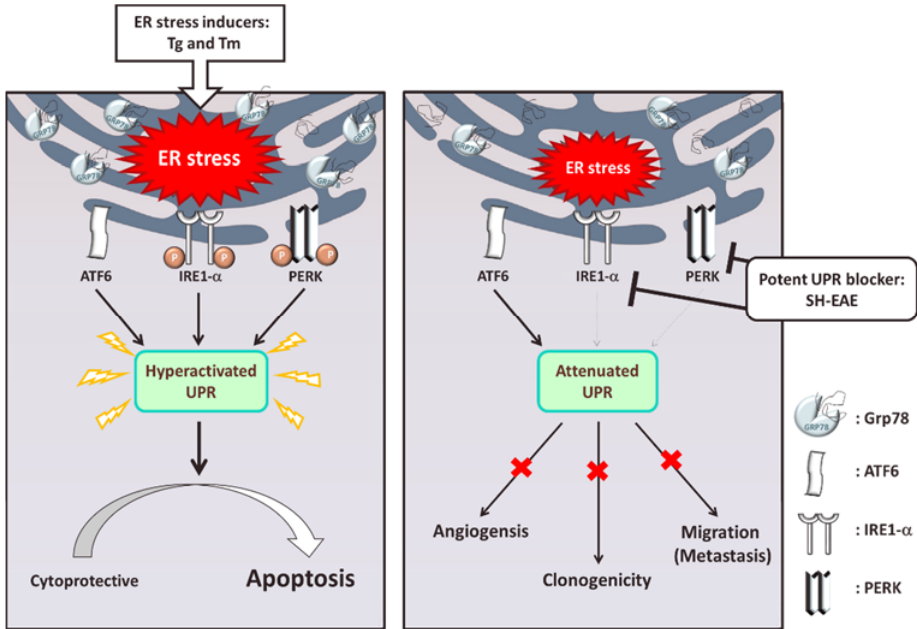
Figure 11. A proposed model of SH-EAE on anti-lung cancer effects through UPR modulation. Unfolded protein response (UPR) is a cytoprotective mechanism that alleviates the protein-folding burden in eukaryotic organisms. Both tunicamycin (Tm) and thapsigargin (Tg) cause a large accumulation of GRP78 chaperones in the ER lumen and the activation of all three sensors of ER stress ATF6, IRE1 α , and PERK. This results in the hyperactivated UPR and the consequent growth arrest and apoptosis in cells. In contrast, SH-EAE selectively inhibited the clonogenicity, migration, and invasion in lung non-small cell lung cancer (NSCLC) cells through the attenuation of UPR by the downregulation of IRE1 α and